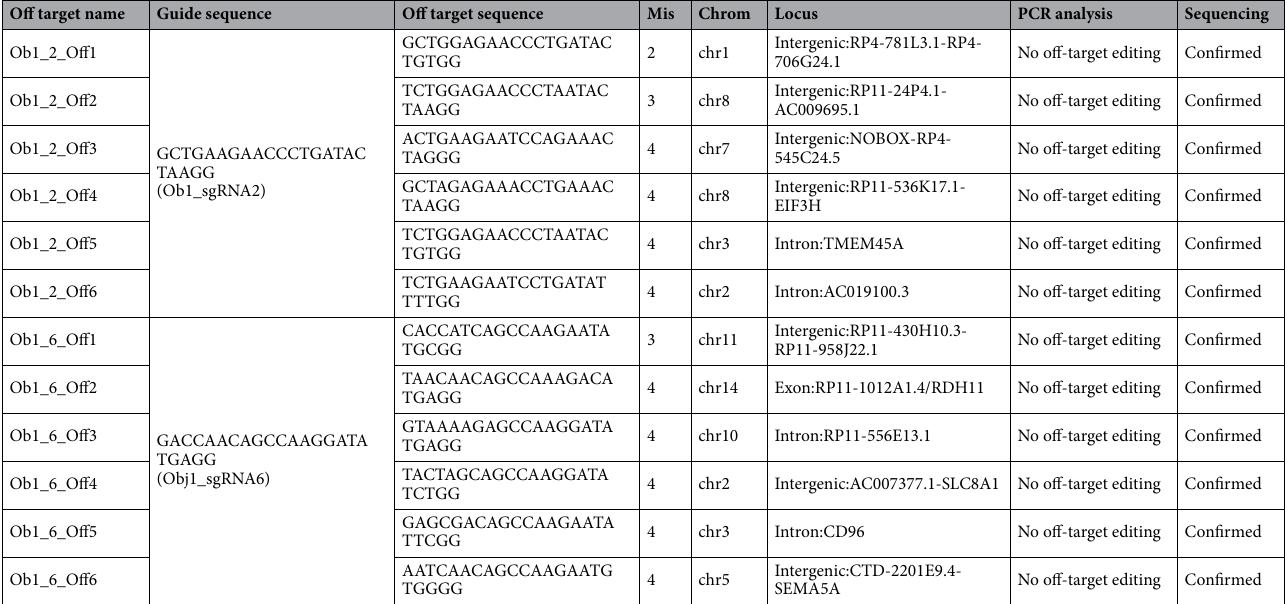
Table 2. Objective 1 potential off-target sites analyses. Top 6 off-target sequences of Obj1_sgRNA2 and Obj1_sgRNA6 identified with CRISPOR webtool, including the mismatches between sgRNAs, the off-target sequence, the chromosomes and loci targeted. All of them were analysed by PCR and Sanger sequencing, and no off-targets were